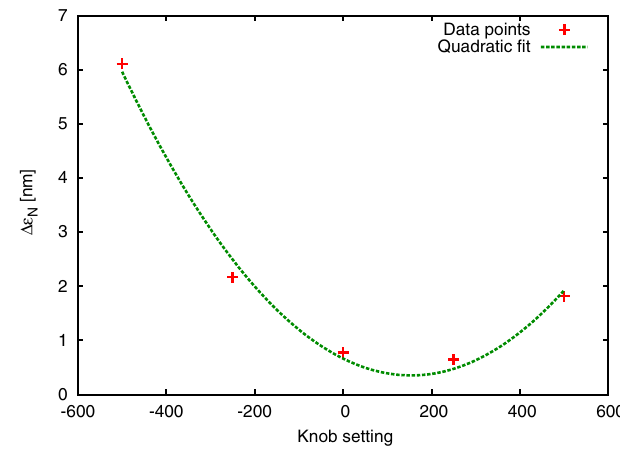
FIG. 3. The optimal knob setting is obtained by fitting a quadratic function to the emittance values measured for five different knob